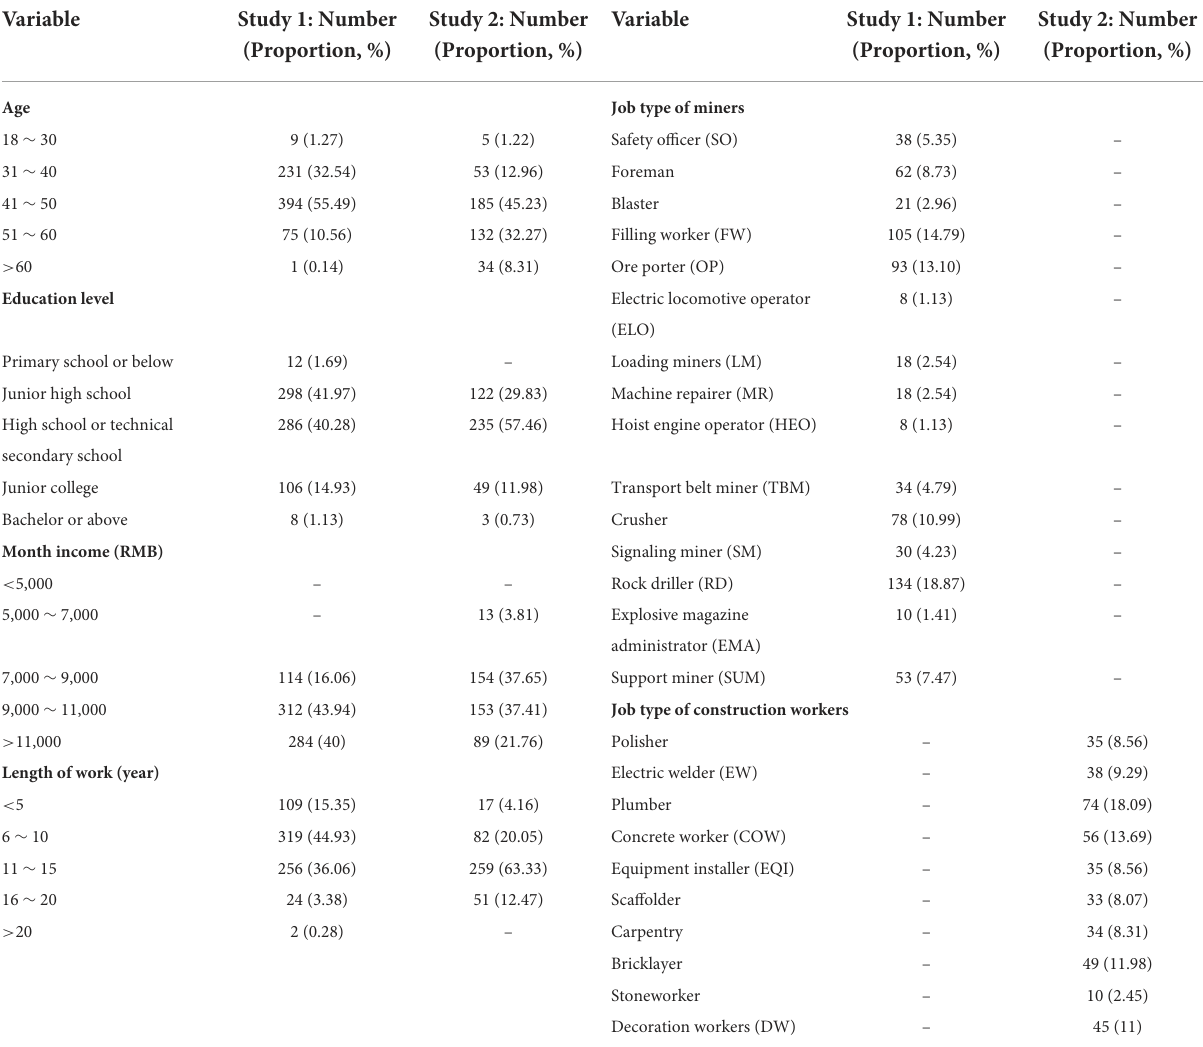
TABLE 1 Demographic information of the respondents in study 1 and study